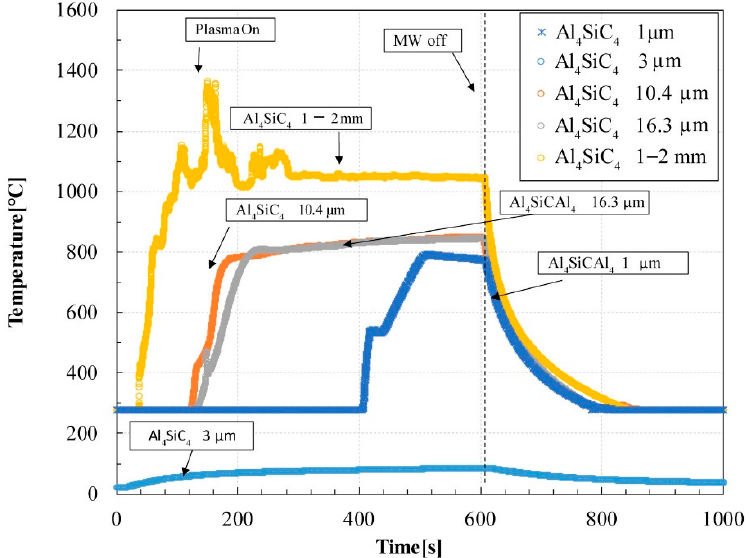
Figure 3. Time vs. temperature plots of Al 4 SiC 4 samples (weight = 1.0 g) heated in a TE 103 cavity. Microwaves generated at a rated power of 200 W were focused on the sample, which was maintained in dry air conditions (0.6 L/min flow) during the heating experiment.